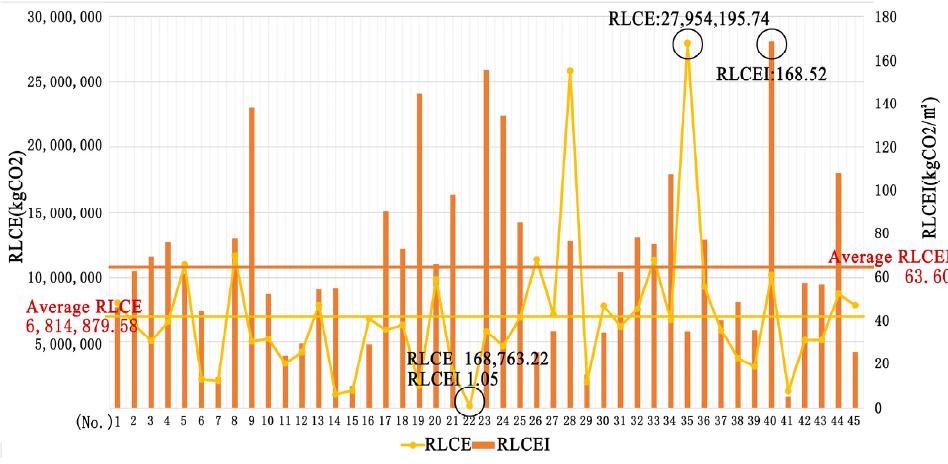
Figure 3. The value of RLCE and RLCEI. Using scatter plot analysis, it can be seen that a higher BA is often accompanied by higher LA and BSC, and a higher BH is often accompanied by lower BSC and higher FAR (Figure 4). With BA ranging from 30,800 m 2 to 1,125,422 m 2 , LA increases from 18,501 m 2 to 796,499 m 2 and BSC increases from 0.50 to 5.2. With BH ranging from 5 m to 32 m, BSC decreases from 5.19 to 0.60 and FAR increases from 1 to 2.80. Additionally, LCT also correlates with BH, FAR, BSC, and